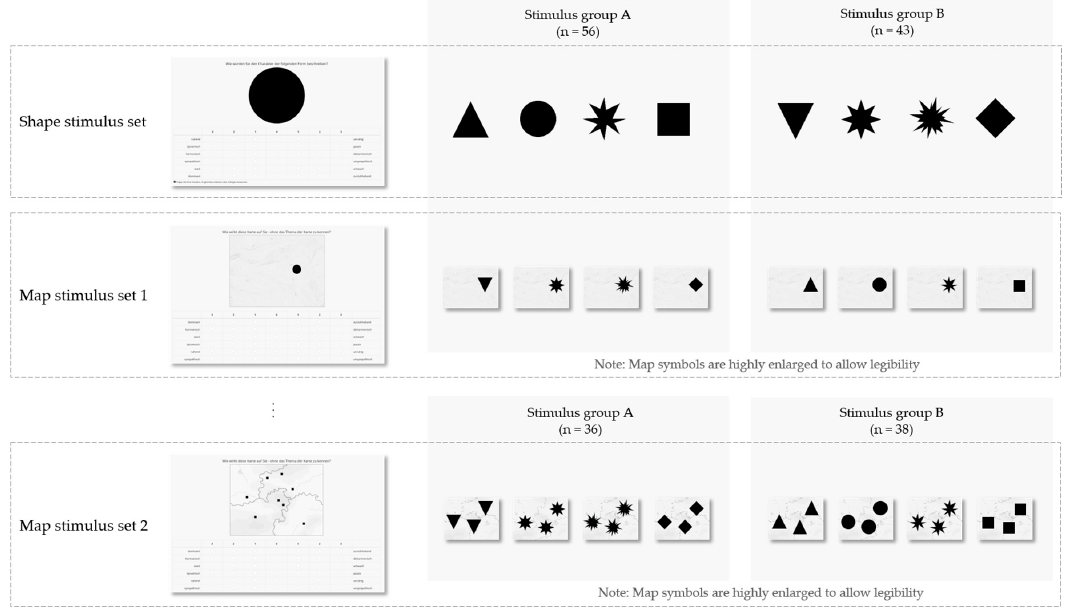
Figure 2. Between-subjects design applied for three stimulus sets. Screenshots of the survey are shown to the left, illustrating the stimulus materials as used in the surveys. Shape and map stimuli used in the study are illustrated to the right, according to the two between-subjects stimulus groups (A and B). Note that map symbols depicted to the right are highly enlarged to enhance legibility.